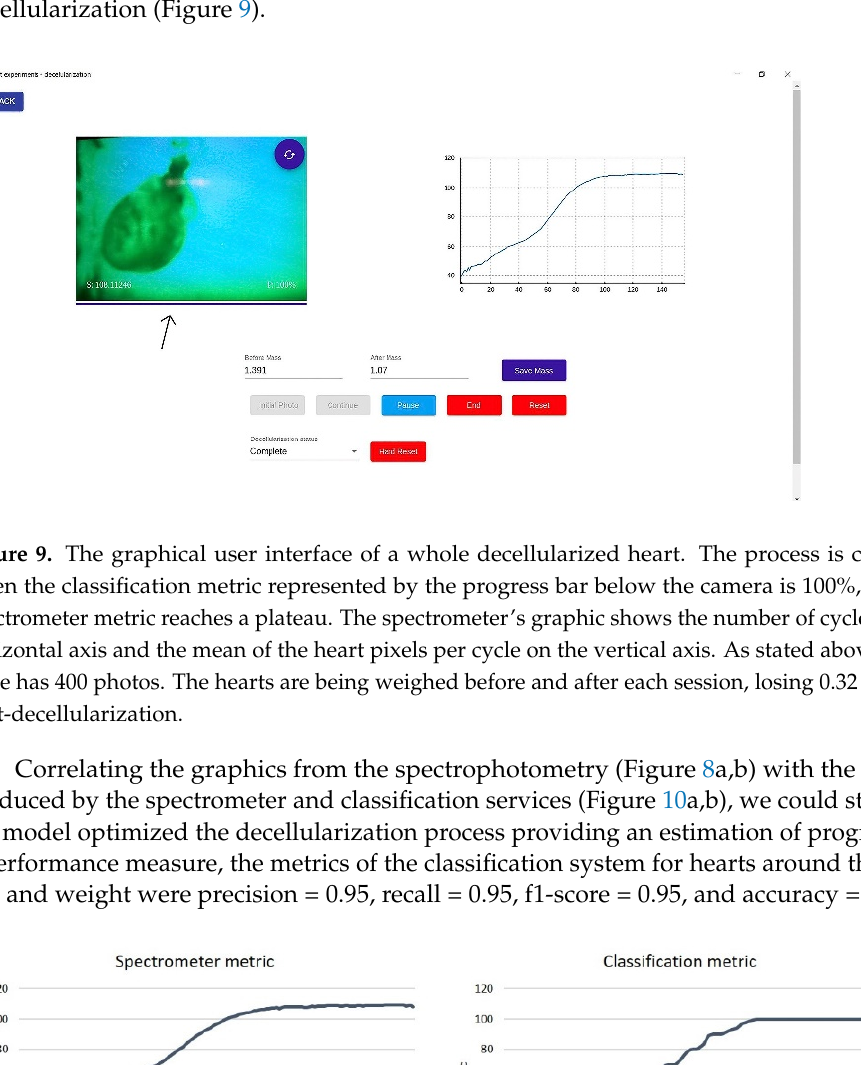
Figure 10. ( a ) Spectrometer metric in time and ( b ) classification metric in time (each point from the horizontal axis is the mean of 400 values collected during a cycle).